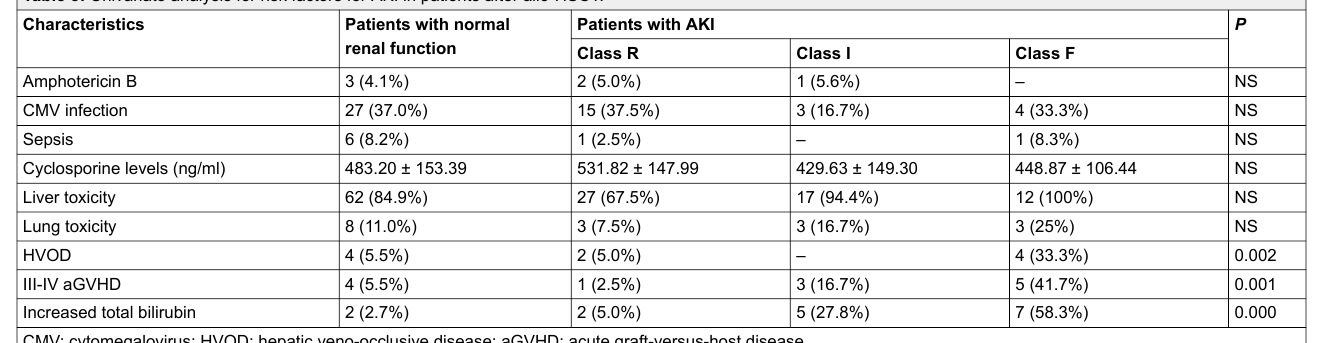
Table 3: Univariate analysis for risk factors for AKI in patients after allo-HSCT.